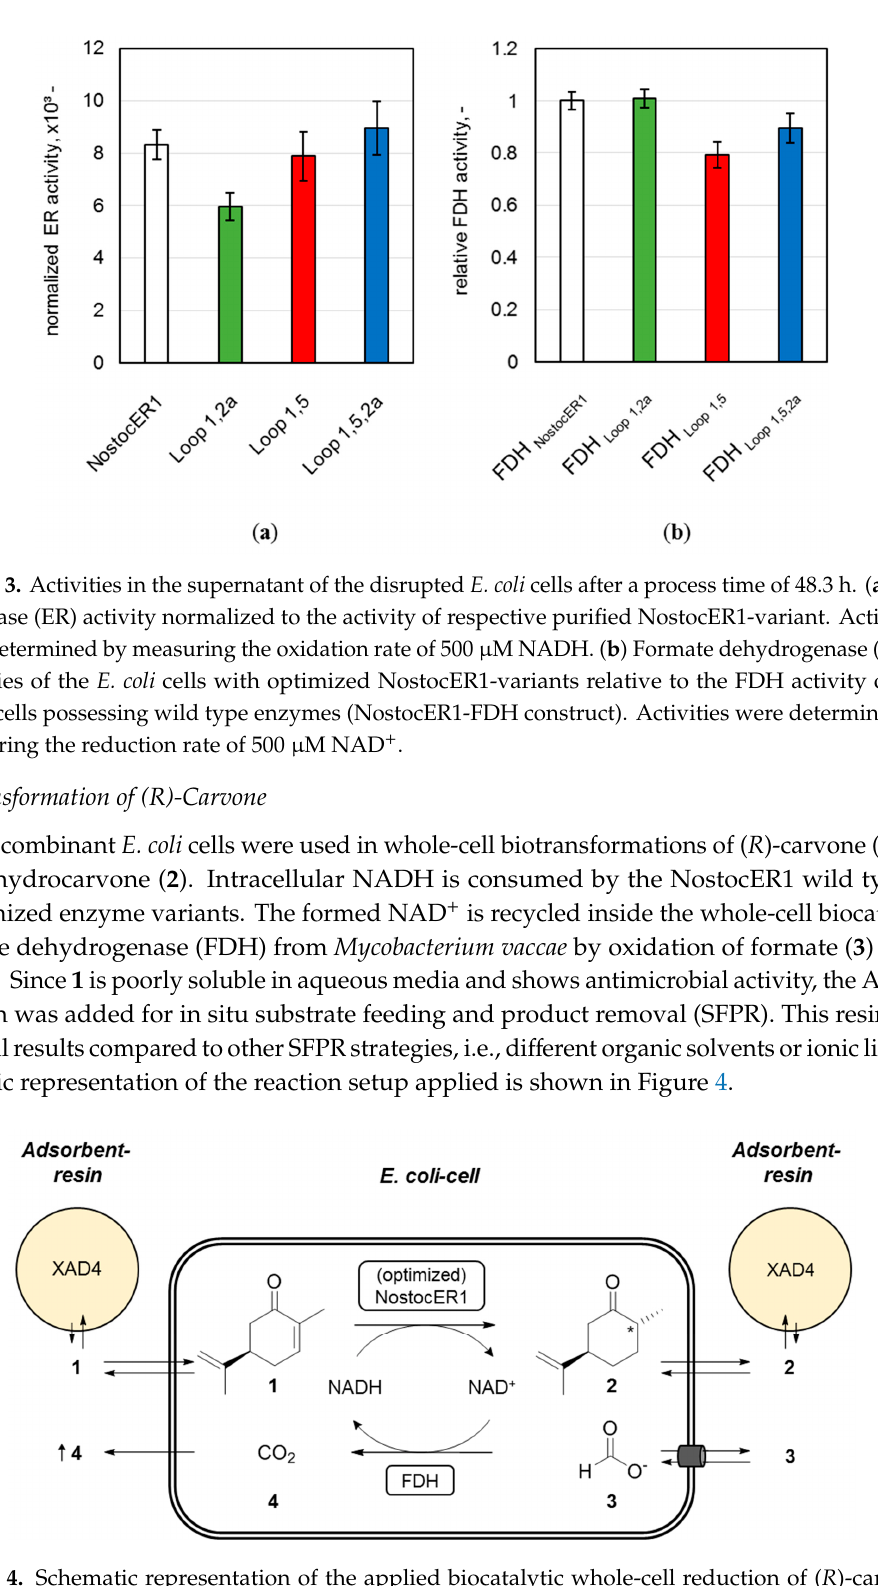
Figure 4. Schematic representation of the applied biocatalytic whole-cell reduction of ( R )-carvone ( 1